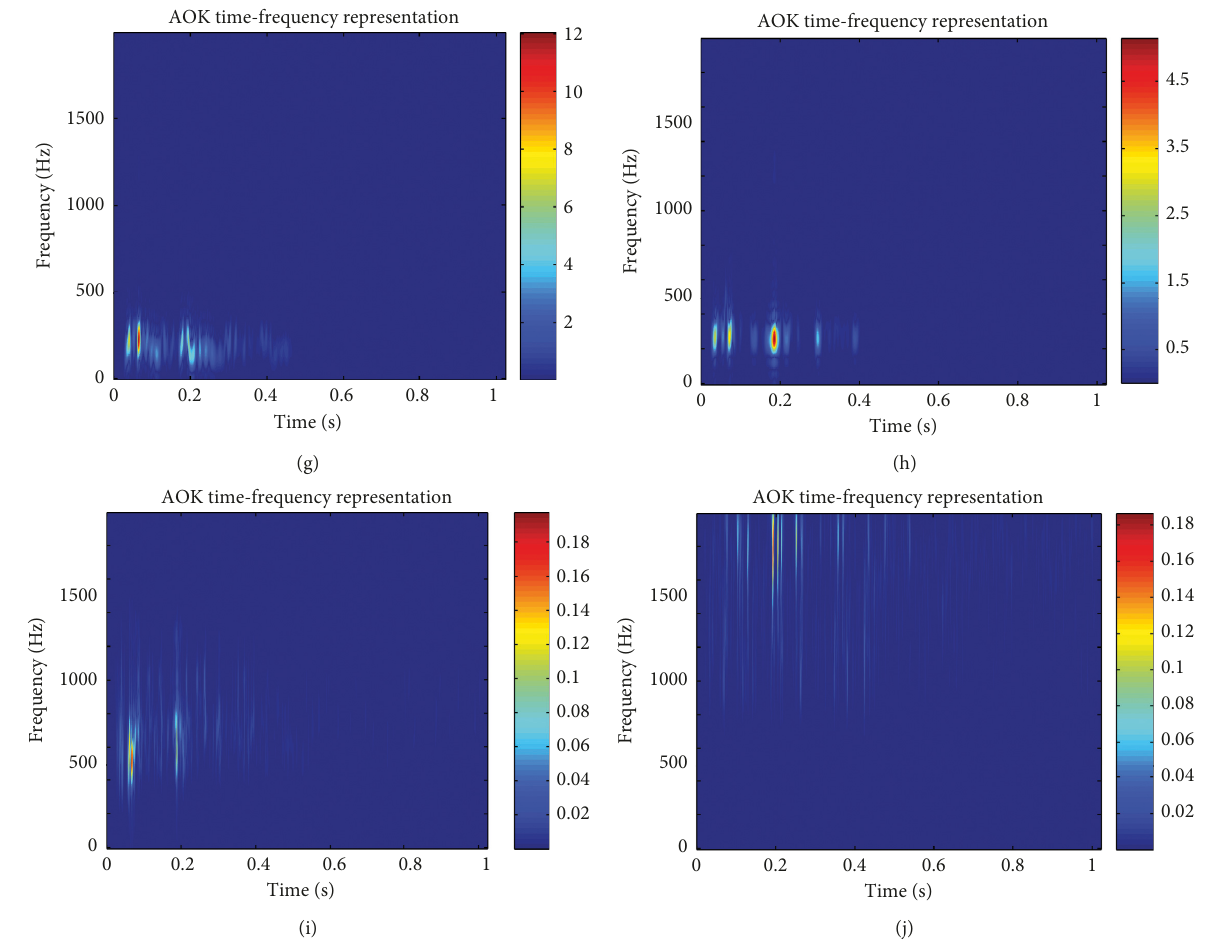
Figure 5: Time-frequency spectrum for each reconstructed signal: (a) as1, (b) a8, (c) d8, (d) d7, (e) d6, (f) d5, (g) d4, (h) d3, (i) d2, and (j) d1. Table 6: Energy components, total energy, and energy proportions of reconstructed signals. Horizontal tangential Horizontal Frequency band